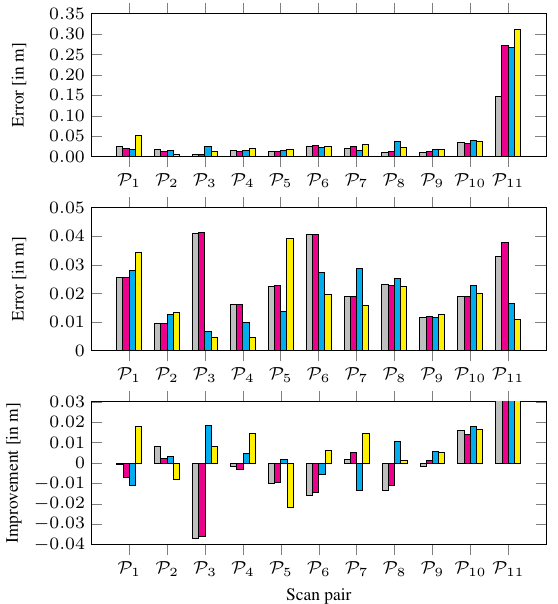
Figure 7. Mean position error after coarse registration (top), af- ter fine registration (center) and the respective improvement (bot- tom) for the scan pairs P i = {S i , S i +1 } when applying no re- liability check (gray) and when applying reliability checks w.r.t. intensity (magenta), range reliability (cyan) or planarity (yellow). Task Number of executions